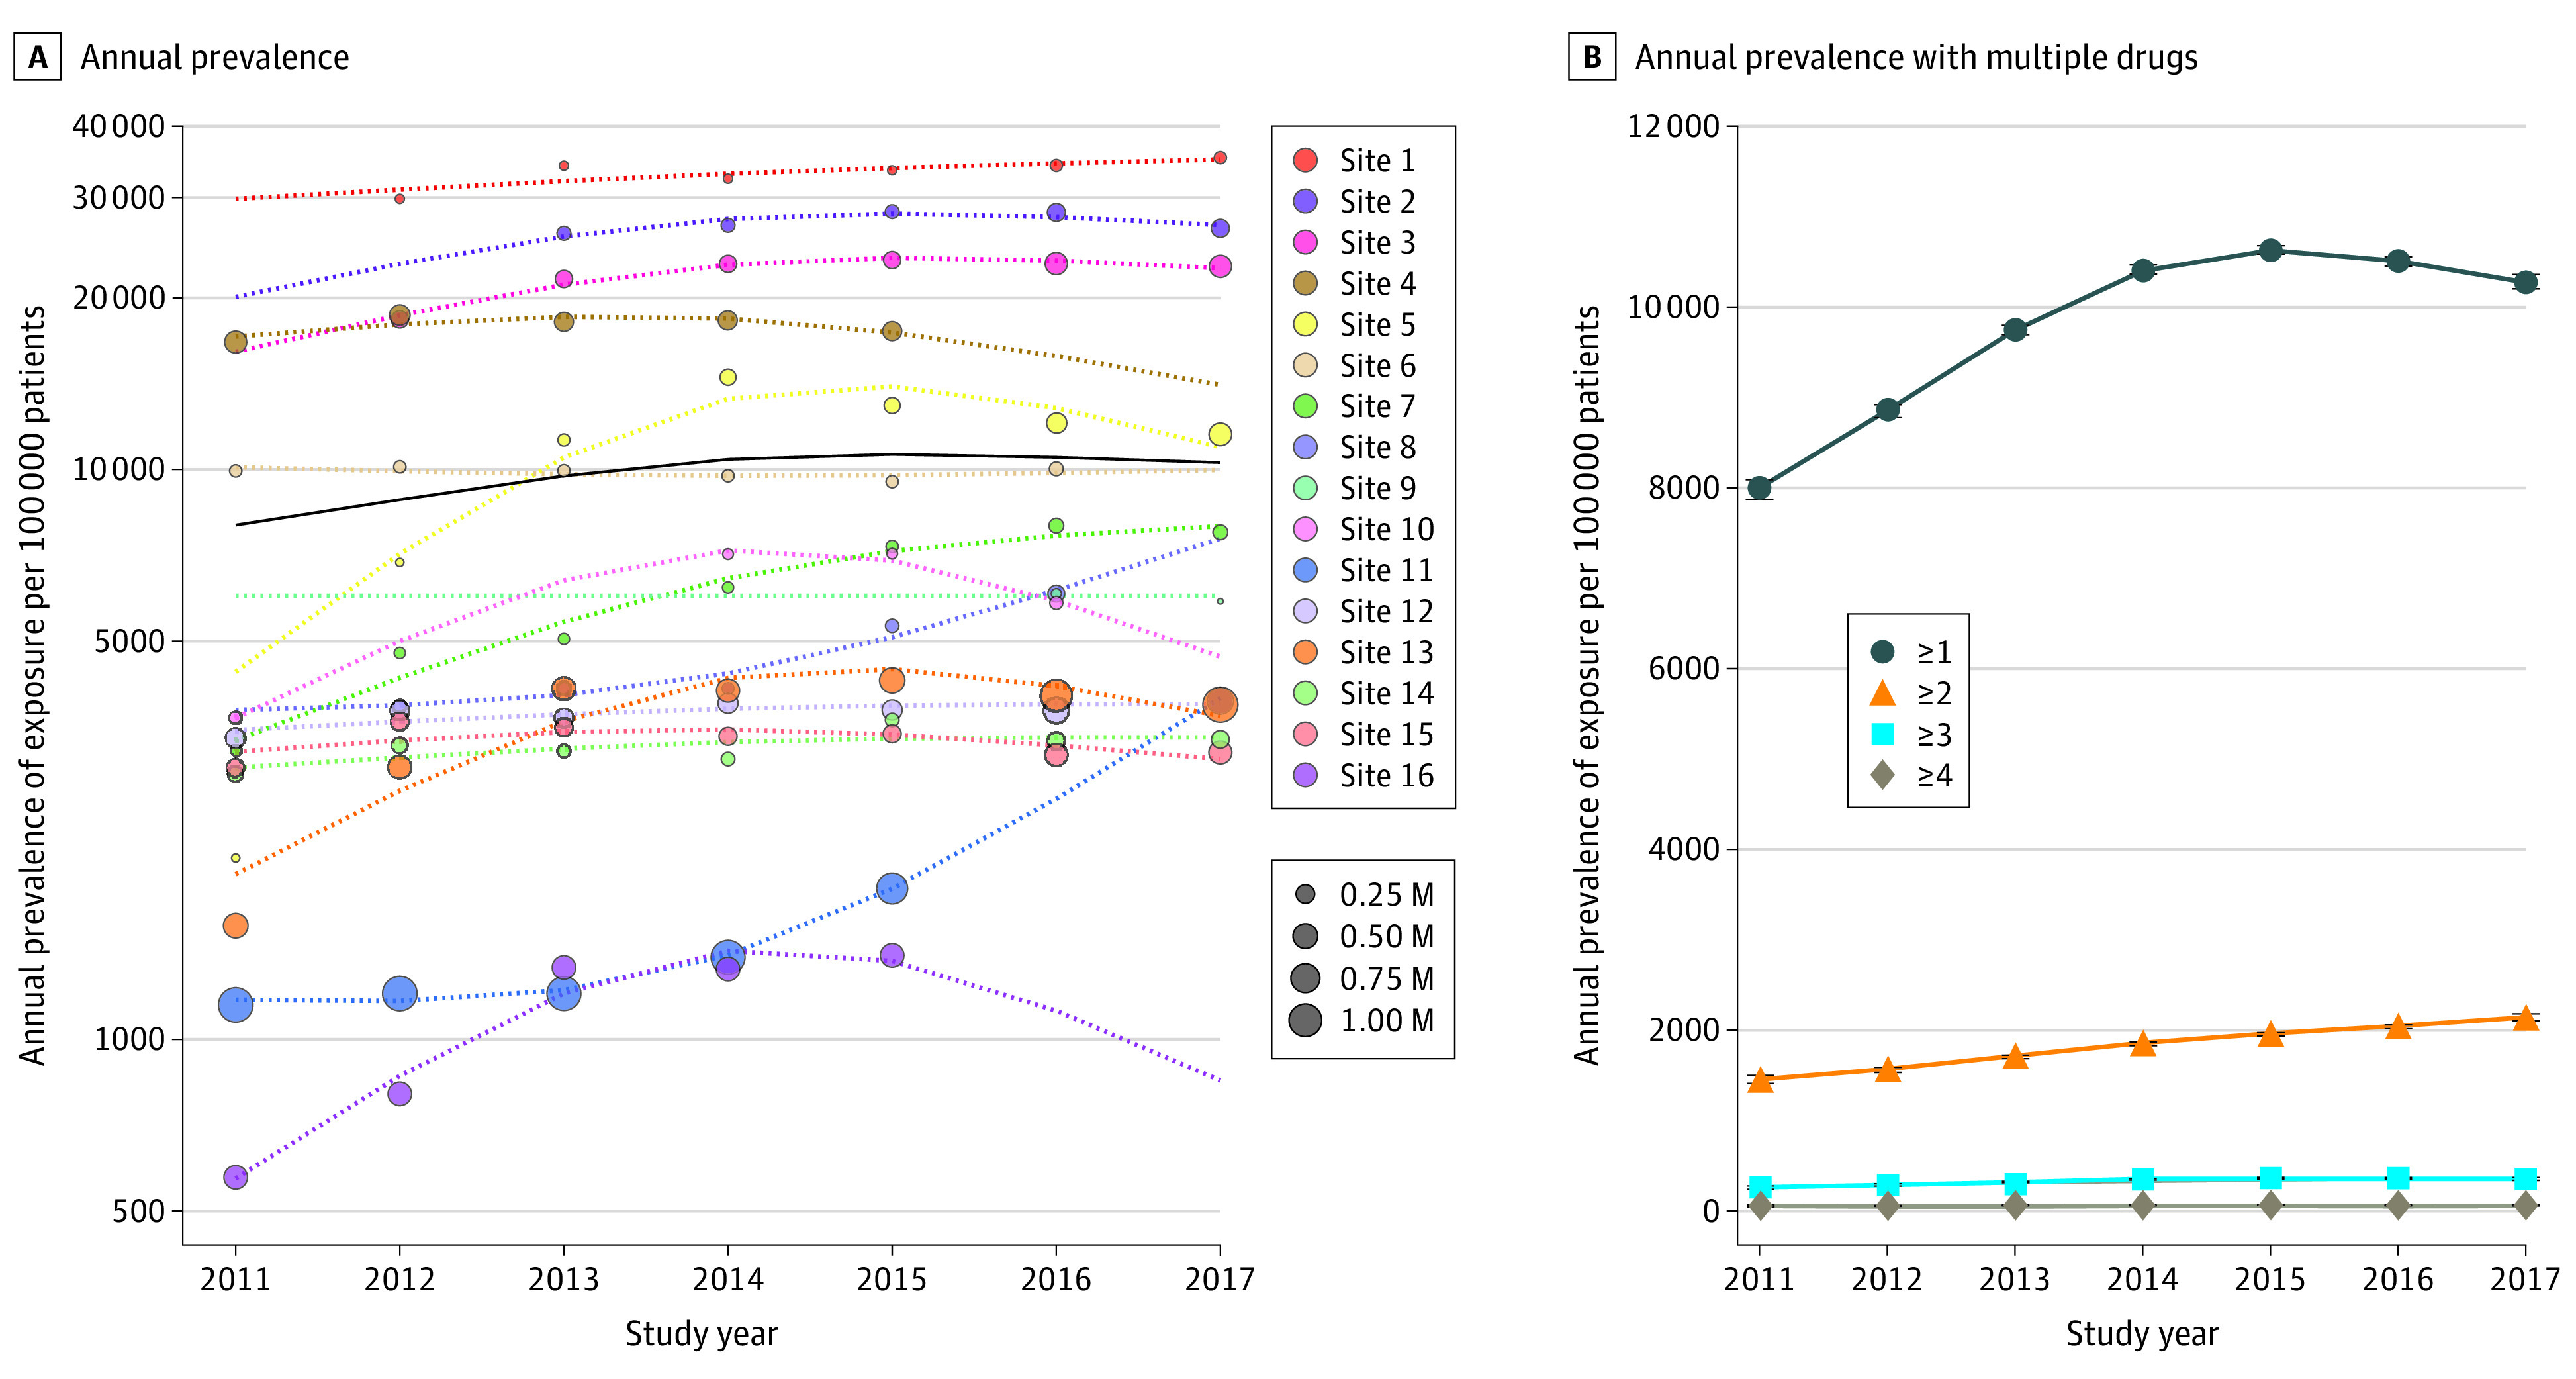
Annual Prevalence of Exposure to at Least 1 Clinical Pharmacogenetics Implementation Consortium (CPIC) Level A Medication by Site and to 1 or More CPIC Level A Medications A, Each circle represents the observed prevalence of exposure for a given site on a log scale. Circles are absent for years when data were not available. The size of the circle is proportional to the number of patients who experienced at least 1 encounter in that year. The dotted lines represent the prevalence of exposure estimated from the model fit. The mean prevalence of exposure across all sites is shown by the solid black line. The 95% CIs for the mean is filled in gray but may be too narrow to observe. B, On a linear scale, the mean annual prevalence of exposure is stratified by the number of CPIC level A medications prescribed. The prevalence of exposure was estimated from the model. The whiskers indicate 95% CIs. M indicates million.